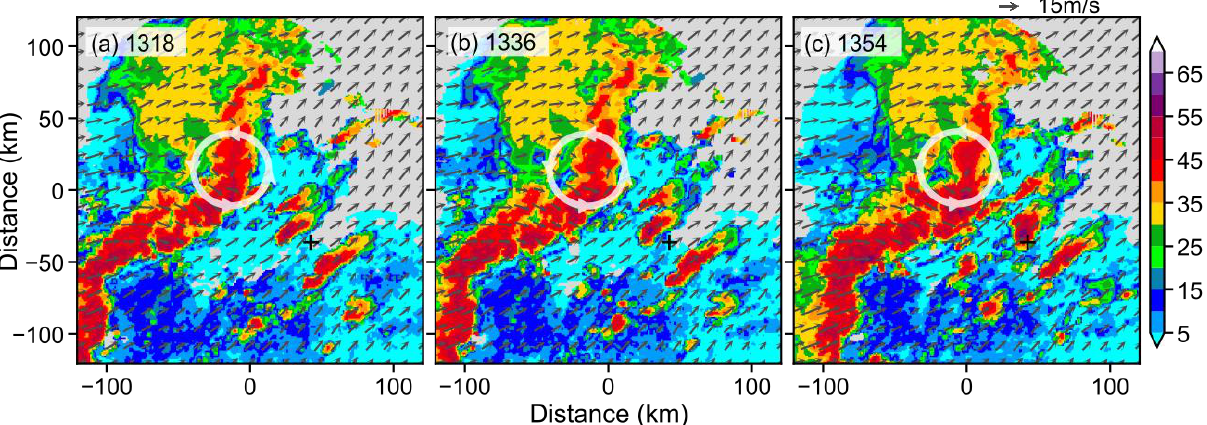
Figure 8. Retrieved horizontal winds (vector) and reflectivity (shaded) near the tornado location on 1 km height at 1318 ( a ), 1336 ( b ) and 1354 ( c ) LTC. The white circle represents the bookend vortex. The black cross represents the tornado location.